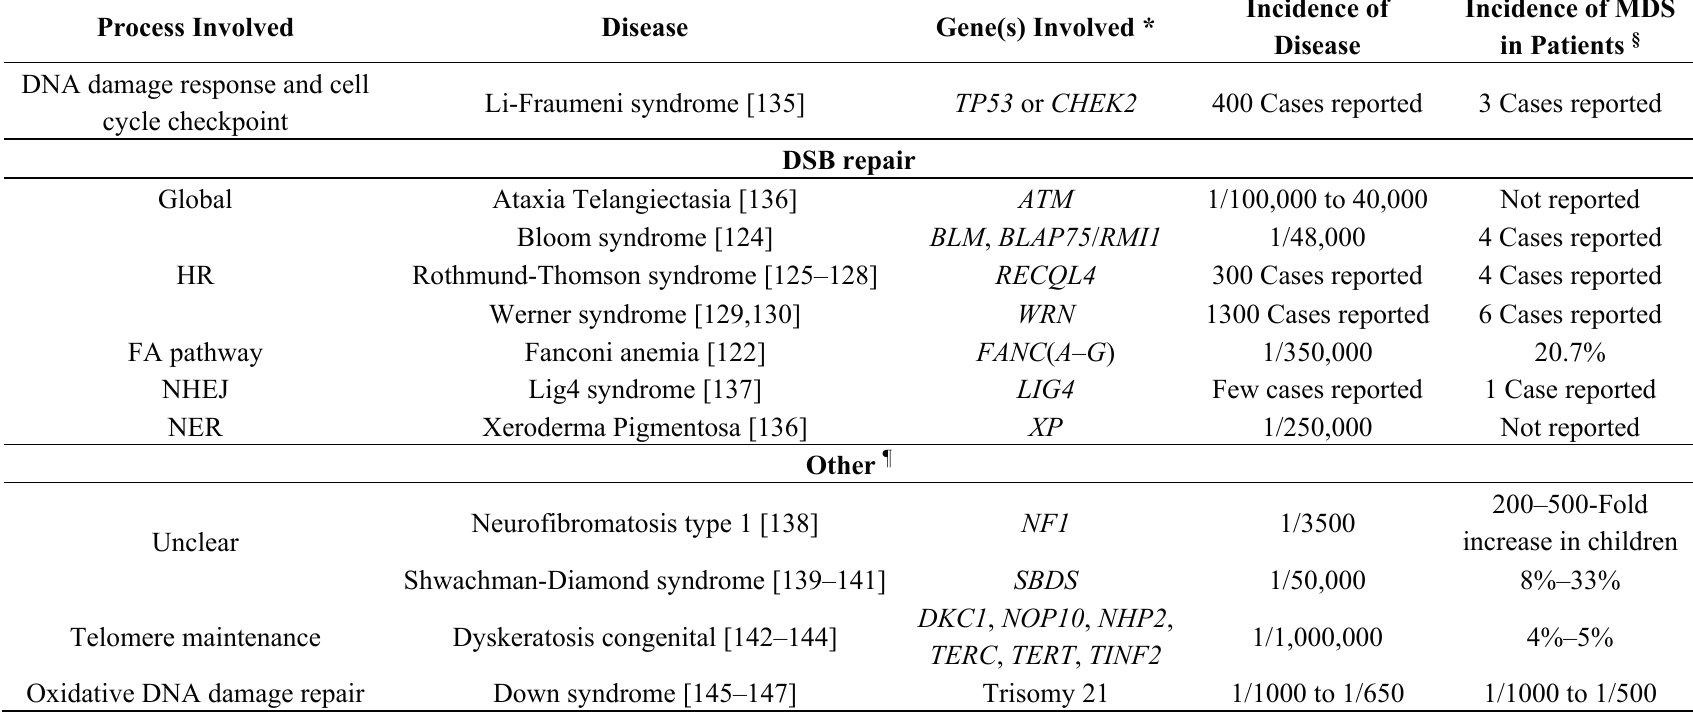
Table 1. Increased incidence of MDS in pediatric syndromes associated with defective DNA